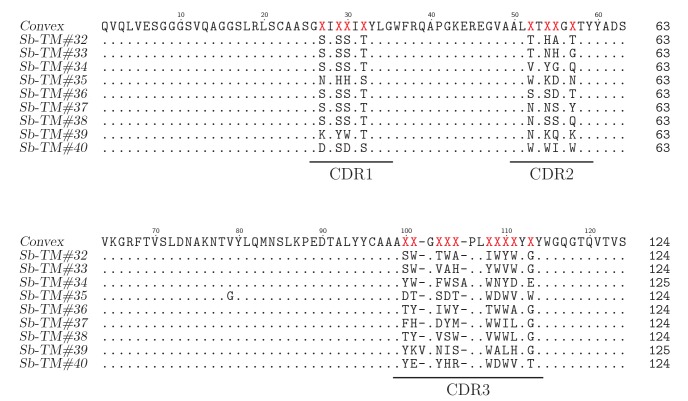
Sequence alignment of convex sybodies raised against TM287/288.